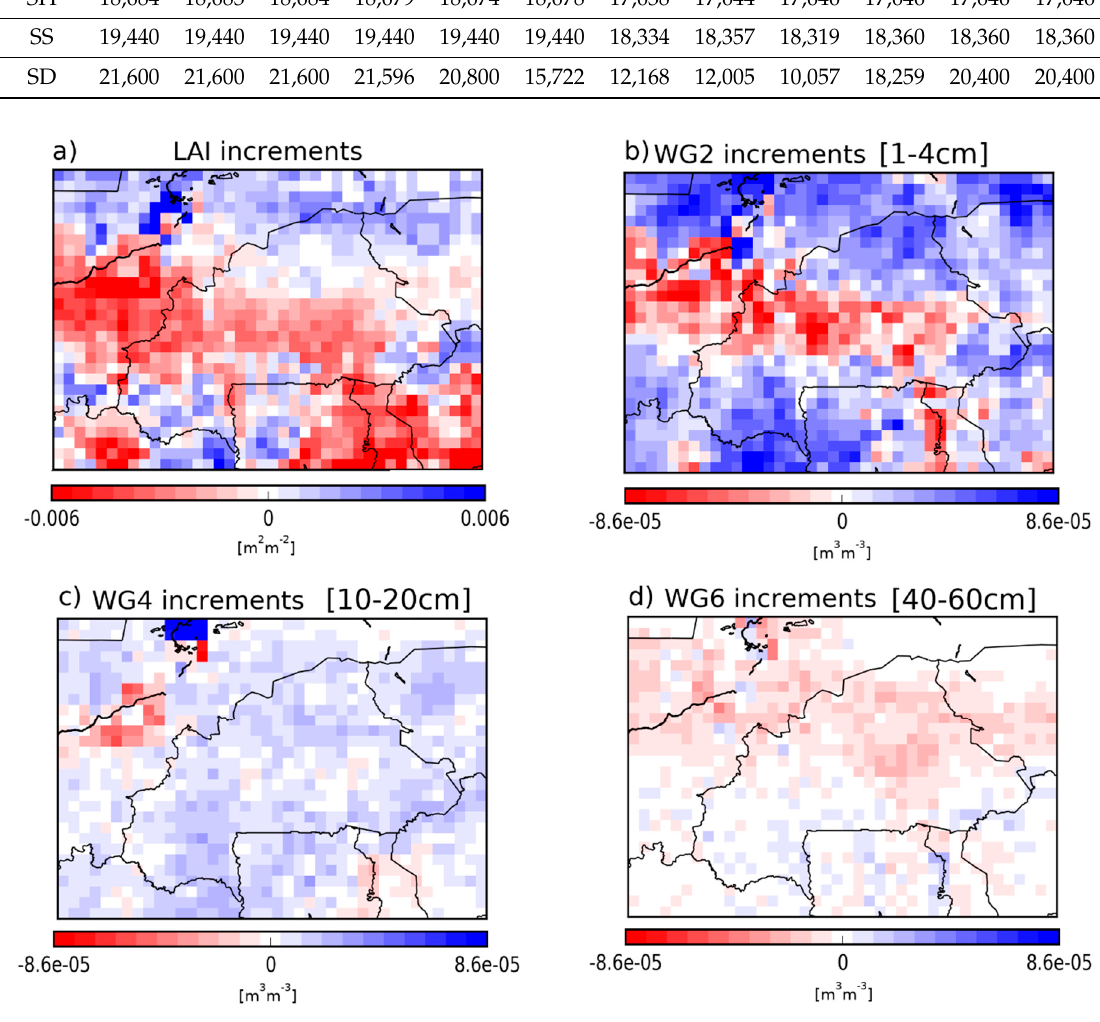
Figure 12. Averaged analysis increments for January 2001 to June 2018. Four control variables are illustrated: ( a ) leaf area index and soil moisture in ( b ) the second (WG2, 1–4 cm), ( c ) fourth (WG4, 10–20 cm), and ( d ) sixth (WG6, 40–60 cm) layer of soil for the LDAS-ERA5 configuration.